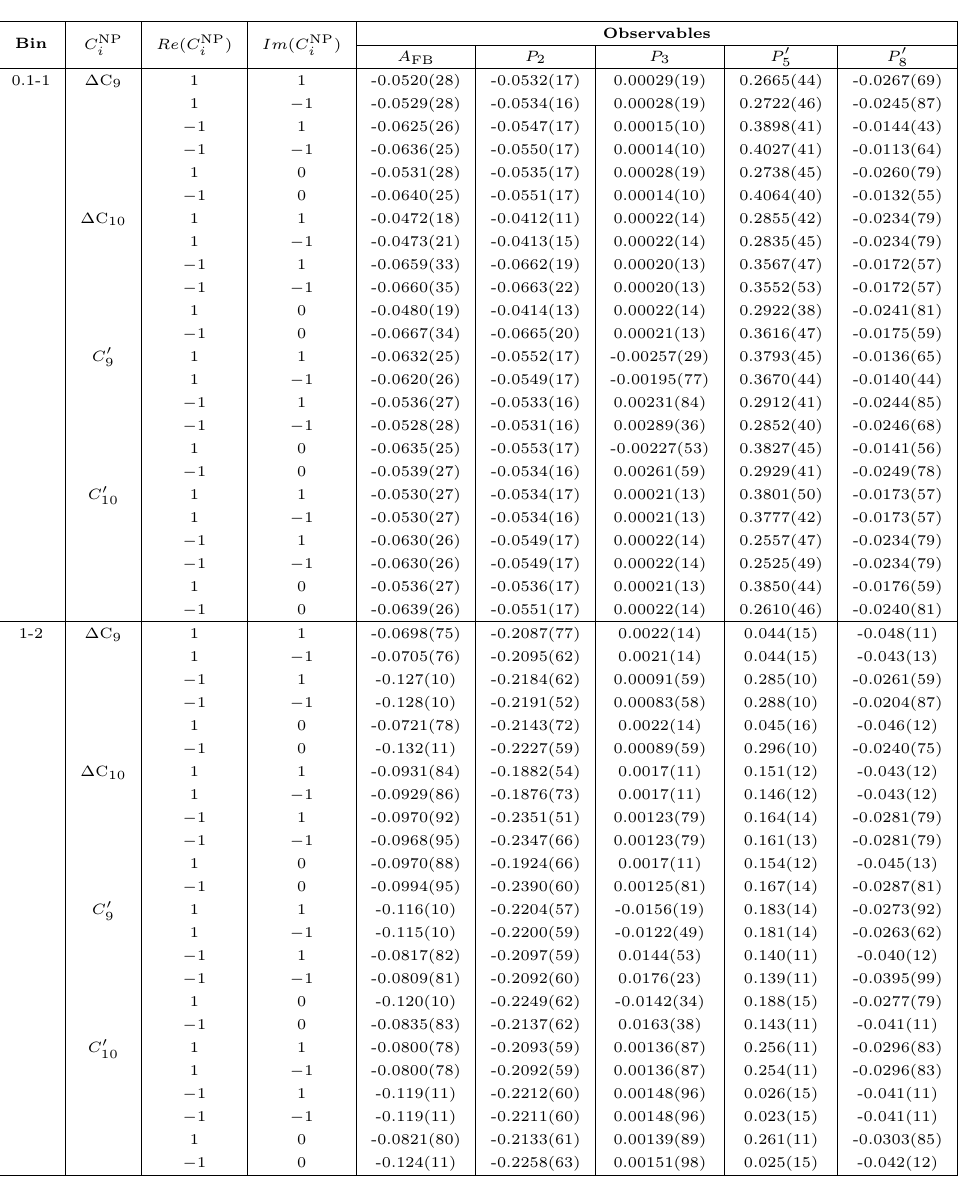
¯ B 0 ( B 0 ) → ρ 0 ll which and C 0 9 , 10 9 , 10